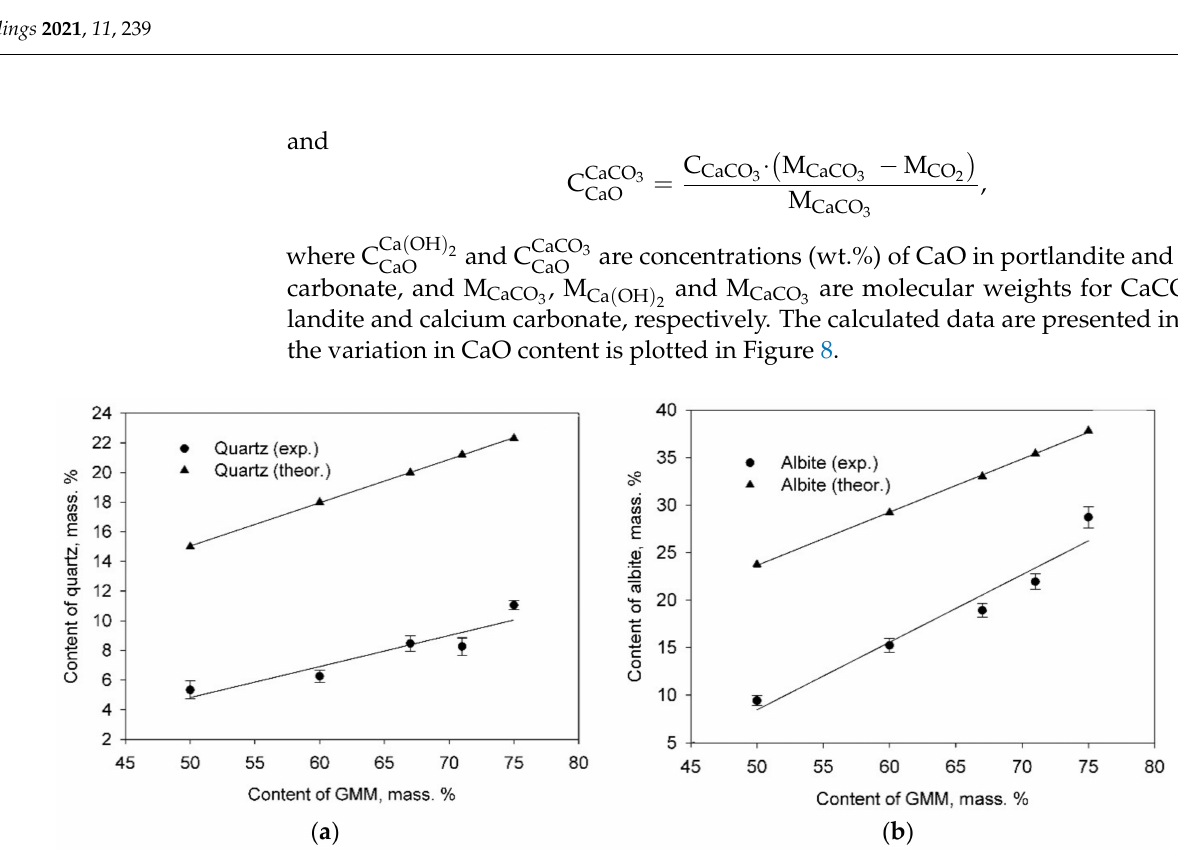
Figure 7. Theoretical and experimental data lines of content variations for quartz ( a ) and albite ( b ) in the binding system. Experimental data are approximated by linear function.